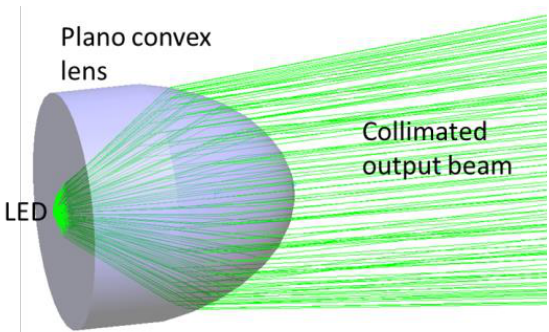
Figure 4. Solid model of the plano-convex lens for LED collimation. Table 1. Design parameters for the plano-convex lens.